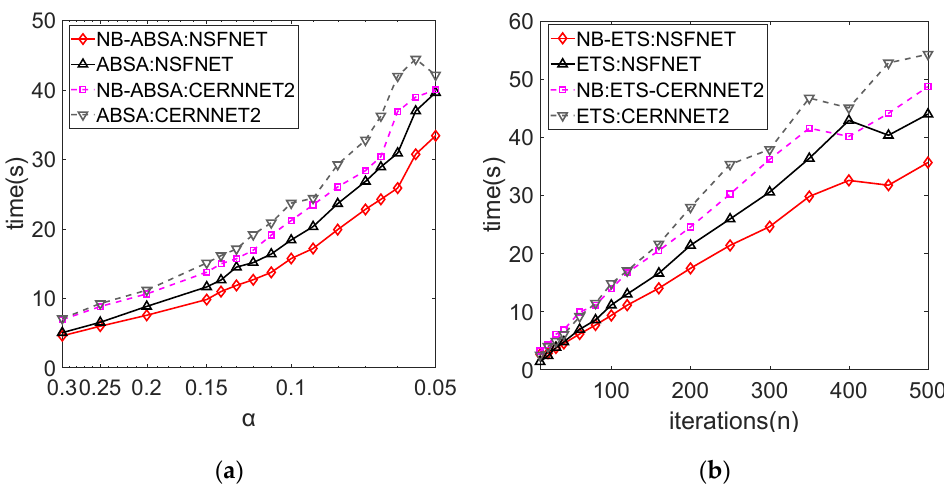
Figure 5. Time performance of heuristic SFC deployment algorithm based on NBACO-SS: ( a ) NB-ABSA; ( b ) NB-ETS.